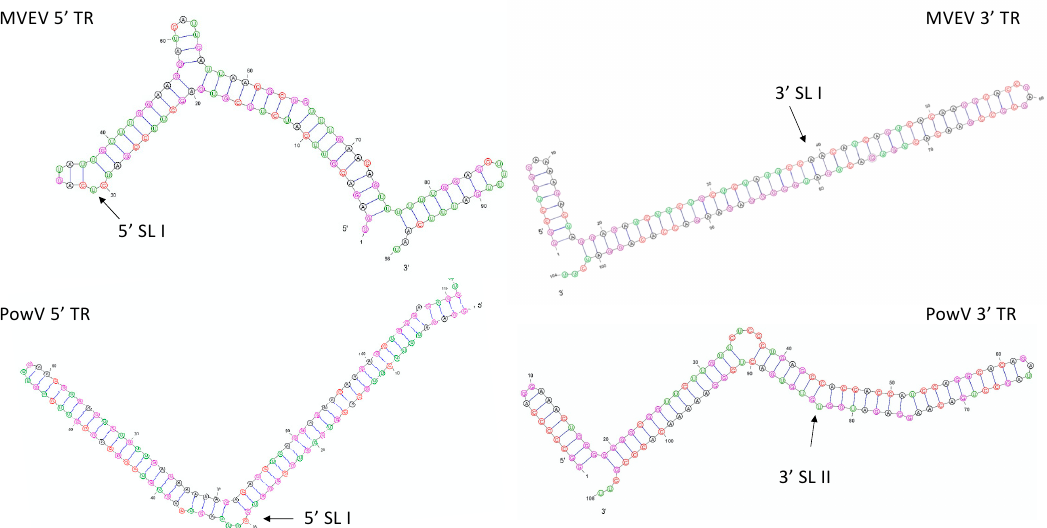
Figure 1. Lowest energy predicted secondary structures of Murray Valley encephalitis virus (MVEV) and Powassan virus (PowV) non-coding RNA regions visualized using VARNA [55]. The next three lowest energy structures are presented in Supplementary Figure S2. The arrows represent stem-loop I (SLI) location in 5’ and 3’ TRs.